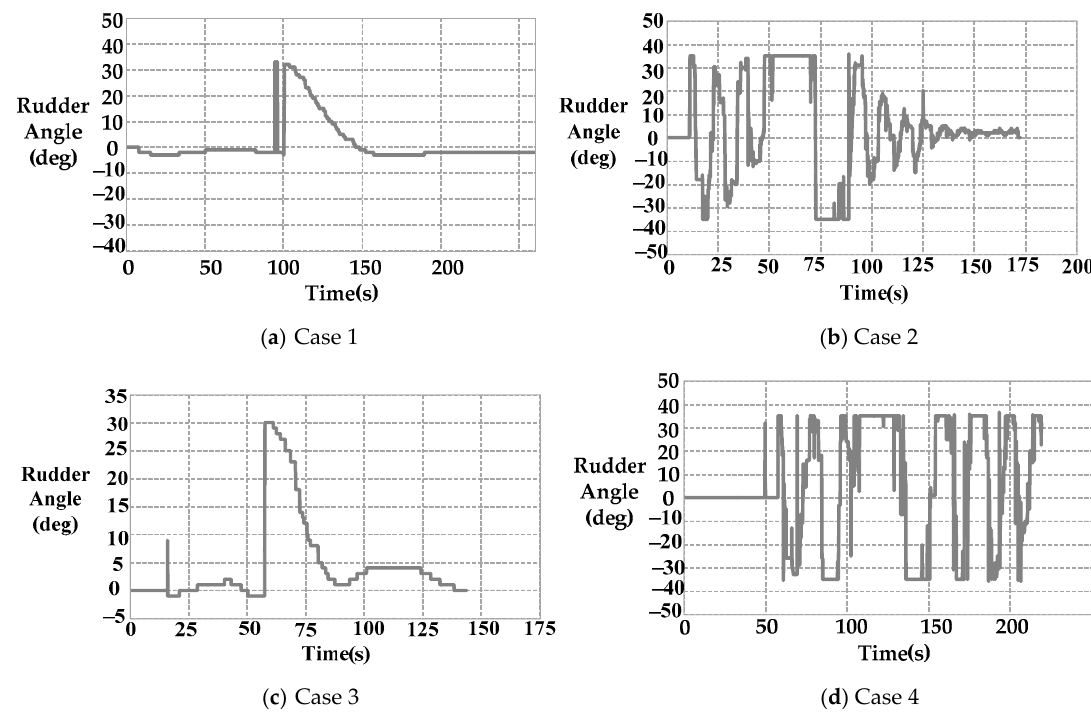
Figure 18 . Ship rudder angle in the tank experiment of ship automatic berthing. Figure 18. Ship rudder angle in the tank experiment of ship automatic berthing.